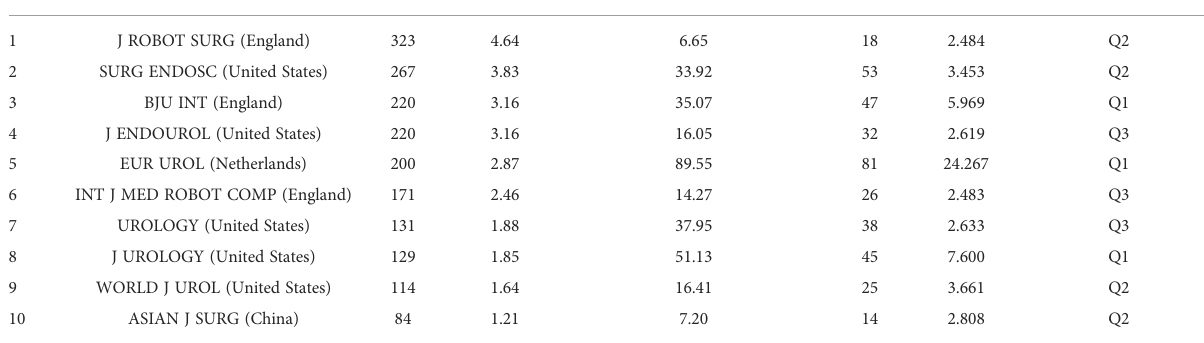
TABLE 3 The top 10 productive journals related to robotic surgery in